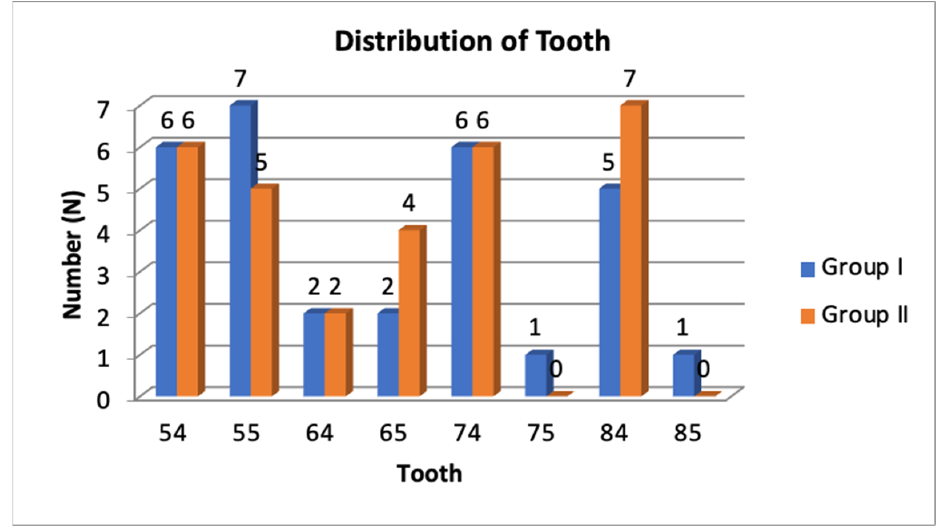
Figure 1. Distribution of teeth in the total